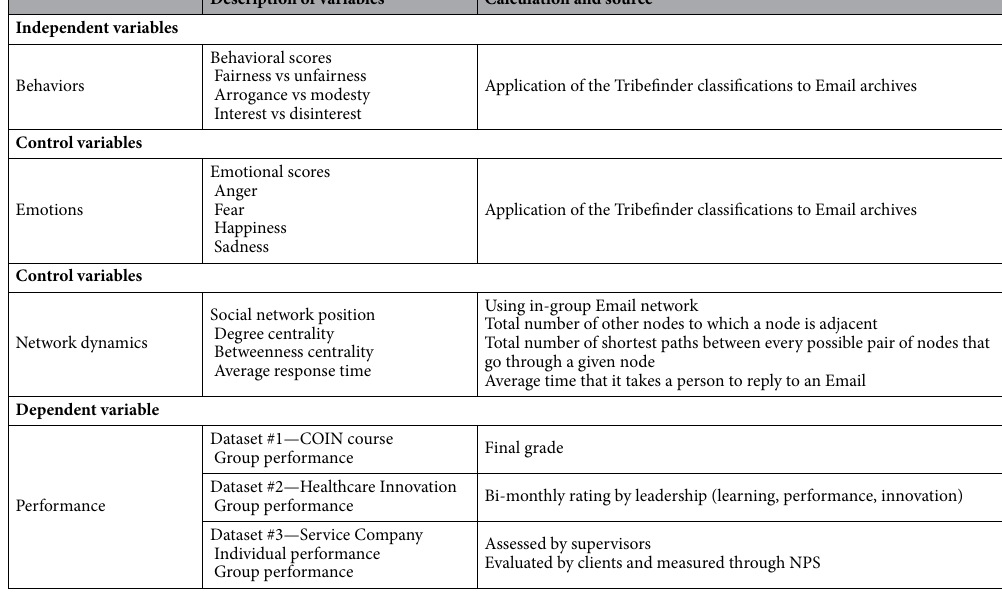
Table 1. Description of the variables.